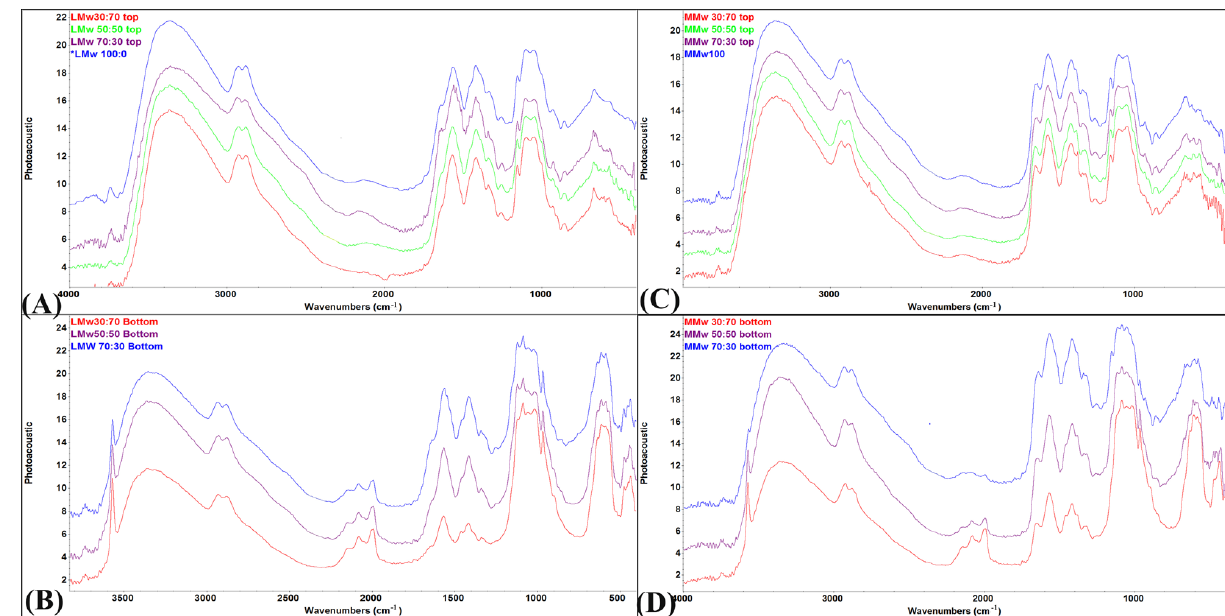
Figure 3. FTIR-PAS spectral profile of ( A ) low molecular weight (LMw) 100:0, 70:30, 50:50 and 30:70 obtained from the top surface; ( B ) LMw 70:30, 50:50 and 30:70 obtained from the bottom surface; ( C ) medium molecular weight (MMw) 100:0, 70:30, 50:50 and 30:70 obtained from the top surface; ( D ) MMw 70:30, 50:50 and 30:70 obtained from the bottom surface.